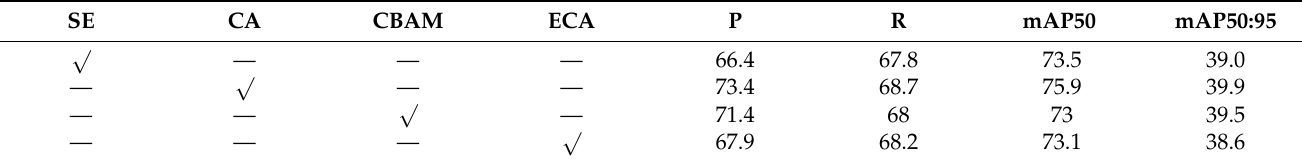
Table 3. Comparison of effects of different attention mechanisms in the ATPF module (NEU- DET dataset).